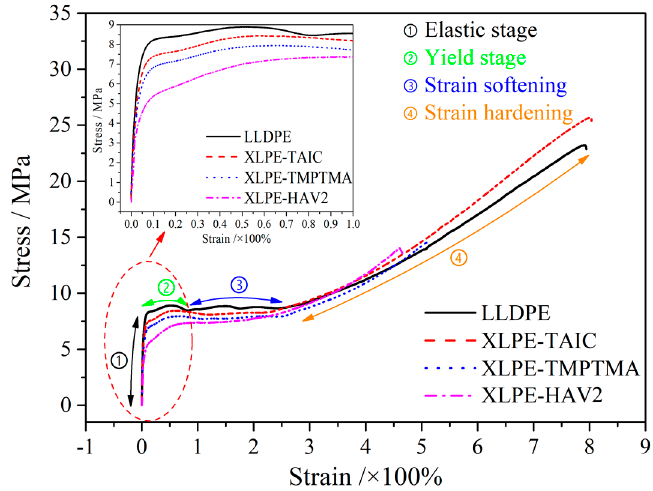
Figure 4. Stress–strain characteristics of LLDPE and UV-XLPE.